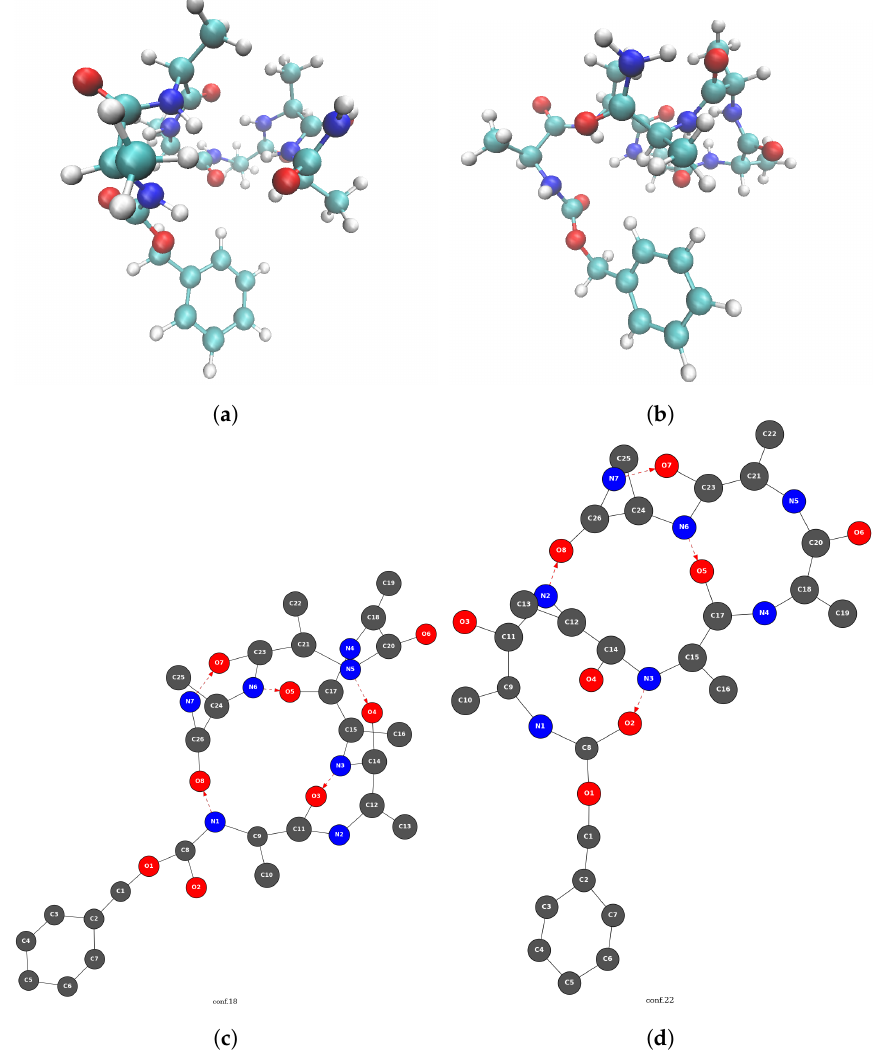
Figure 4. Illustration of two conformers (3D representation, top ( a , b )) and their associated 2D- MolGraphs (bottom ( c , d )) identified in a trajectory of the gas phase Z − Ala 6 − COOH (C 26 H 39 N 7 O 8 ) peptide. Colors for the 3D structures vertices: green for carbon, dark blue for nitrogen, red for oxygen, and light gray for hydrogen atoms. Colors for the 2D-MolGraph vertices: dark gray for carbon, dark blue for nitrogen, and red for oxygen. Solid black edges in the graphs represent covalent bonds, and the red arcs represent the hydrogen bonds directed from the donor to the